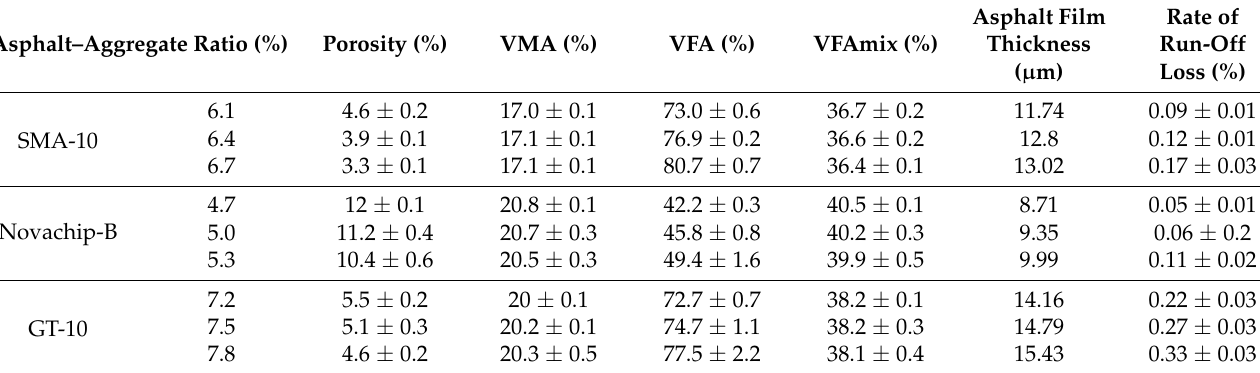
Figure 1. Grading curve of SMA-10-10, Novachip-B, and GT-10. Table 2. Volume index under different asphalt–aggregate